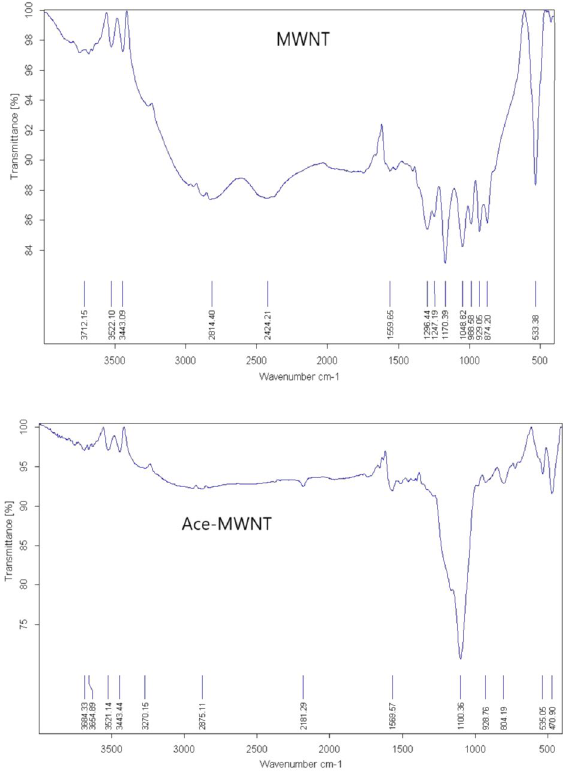
Figure 7. IR Spectrum of Acetamiprid- multi-walled